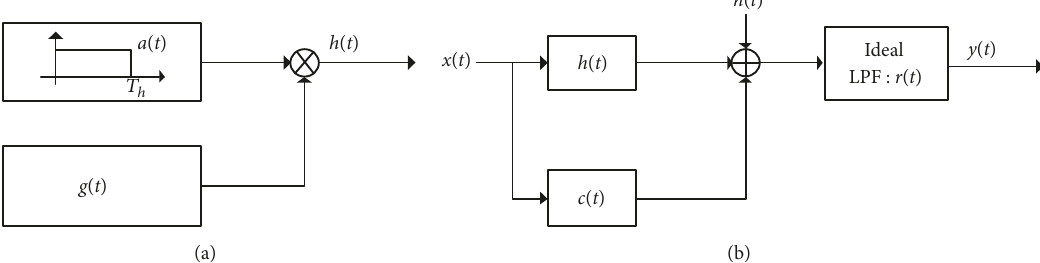
Figure 1: Random target model for waveform design based on MI. (a) Signal model for random target with finite duration 𝑇 ℎ . (b) Signal model for waveform design based on